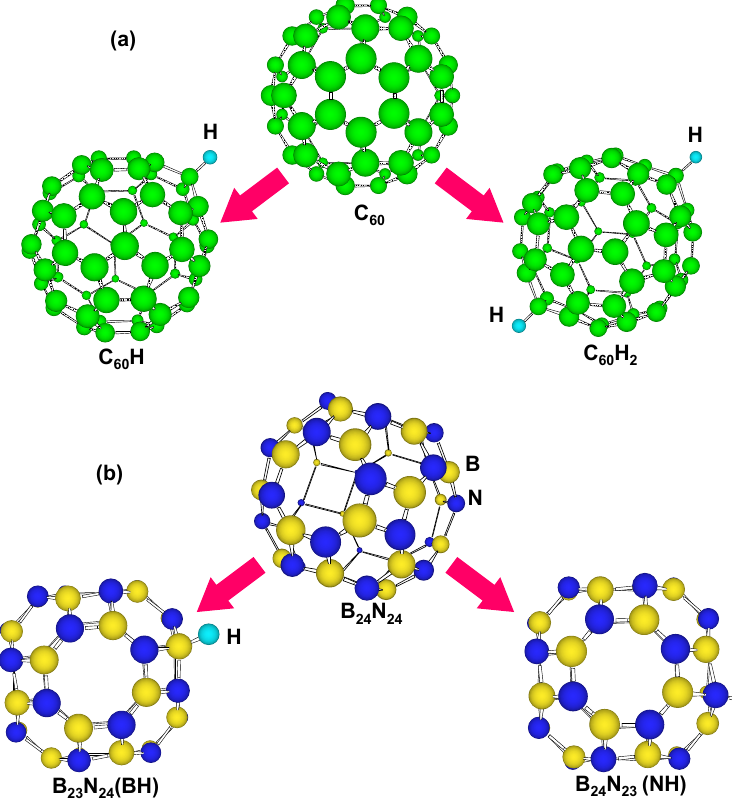
Figure 5. Structural models of H atoms chemisorbed on ( a ) C 60 and ( b ) B 24 N 24